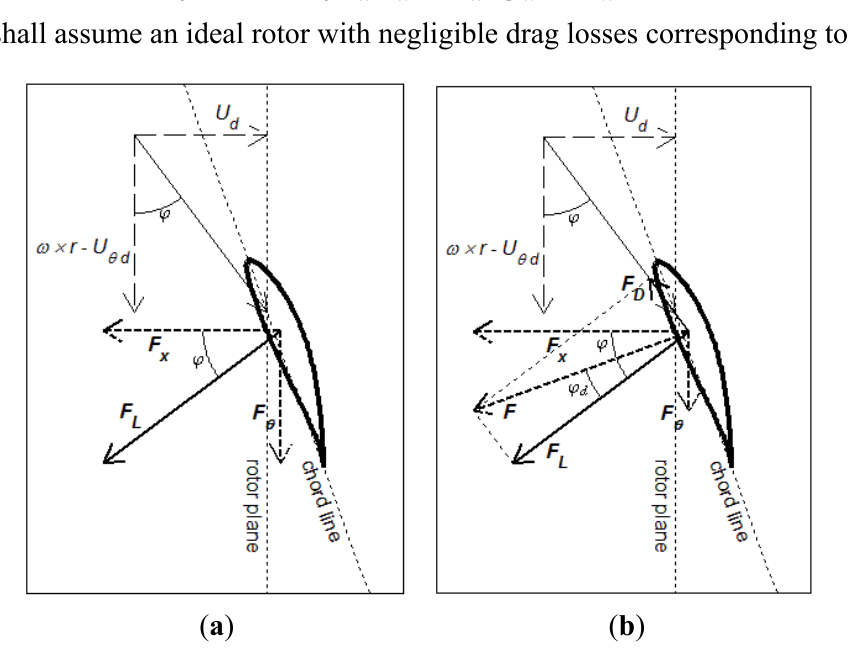
Figure 2. Display of axial and tangential flow components as seen from the rotating blades’ reference. The forces exerted by the rotating blades on the fluid are shown. ( a ) Ideal blade with no drag force; ( b ) Drag force included (drag force magnitude exaggerated for visual